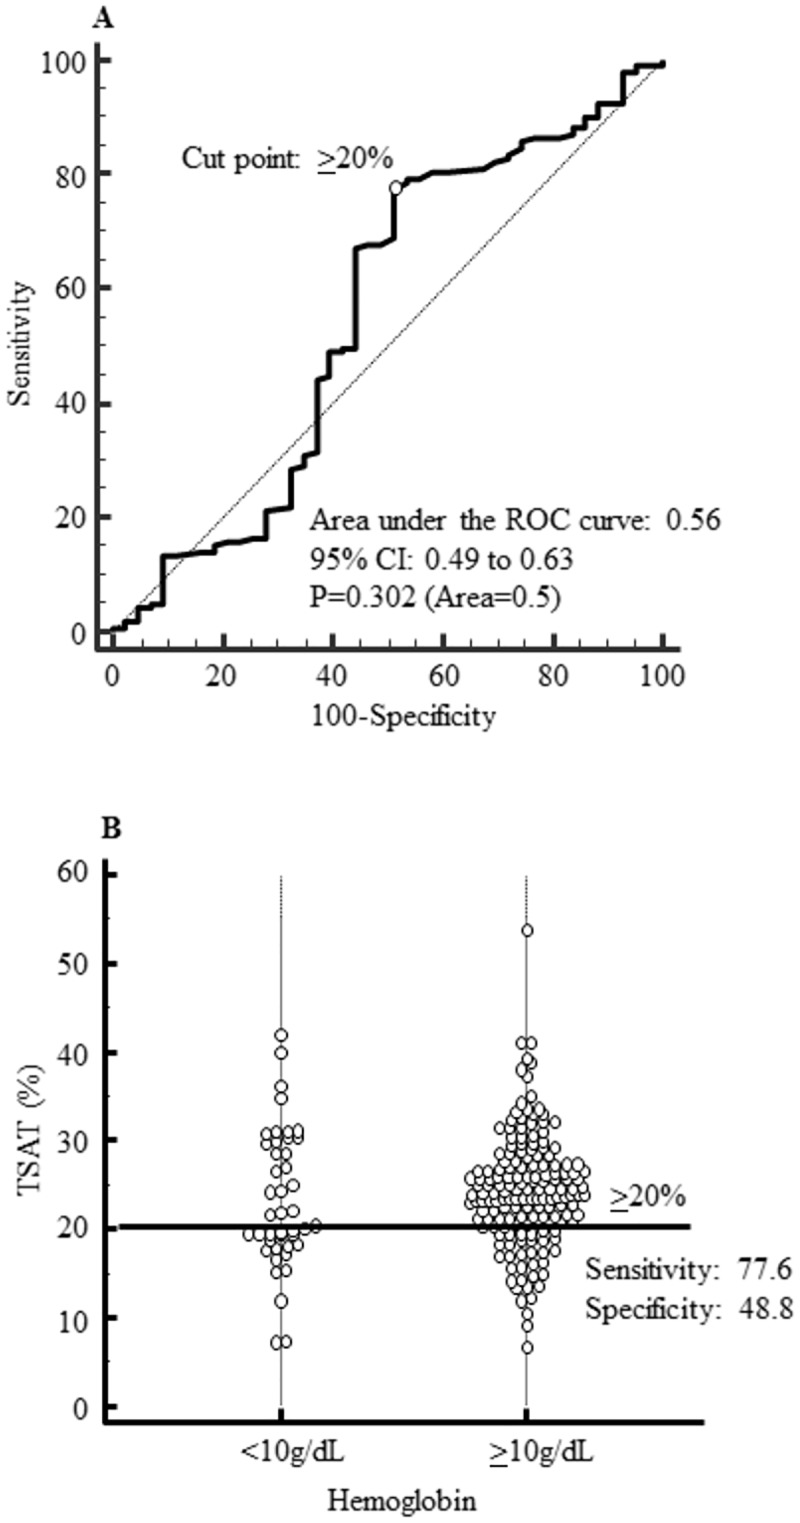
Diagnostic accuracy of transferrin saturation.(A) The ROC curve of transferrin saturation with Hemoglobin ≥10g/dL. (B) Dot plot of transferrin saturation in Hemoglobin <10g/dL and ≥10g/dL. The cutoff point for TSAT was found to be at least 20% (sensitivity: 77.6%, specificity: 48.8%, p = 0.302).